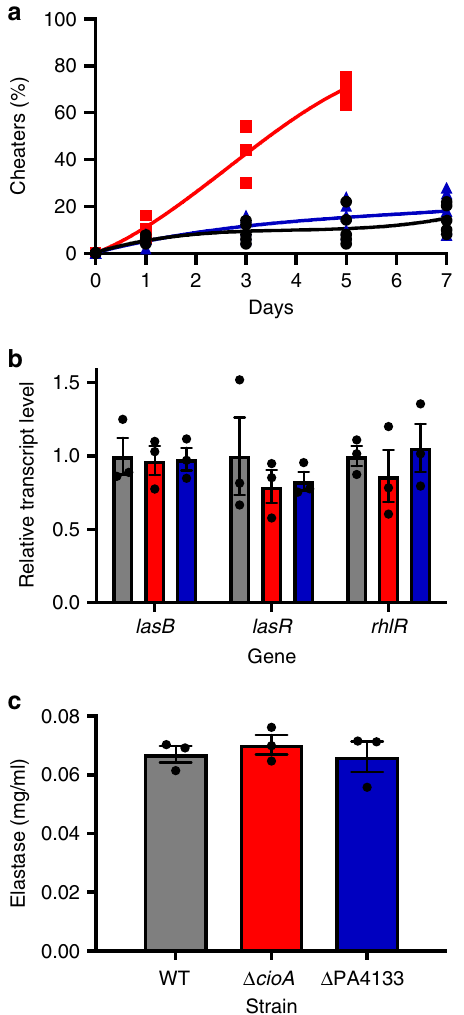
Fig. 3 The cyanide insensitive terminal oxidase Cio mediates self-protection of cooperators. a Competition between WT PAO1 (black), CioA-null cooperator (red), or PA4133-null cooperator (blue) and LasR-null mutants. The initial frequency of cheaters was 0.01. Five biological replicates were performed. Lines represent best- fi t polynomial regressions for each condition. b Expression of lasB, lasR and rhlR in WT PAO1 (black), CioA-null mutant (red), and PA4133-null mutant (blue). c Elastase production by WT PAO1 (black), CioA-null mutant (red), and PA4133-null mutant (blue). For b , c means, s.e.m., and individual biological replicates are shown ( n =